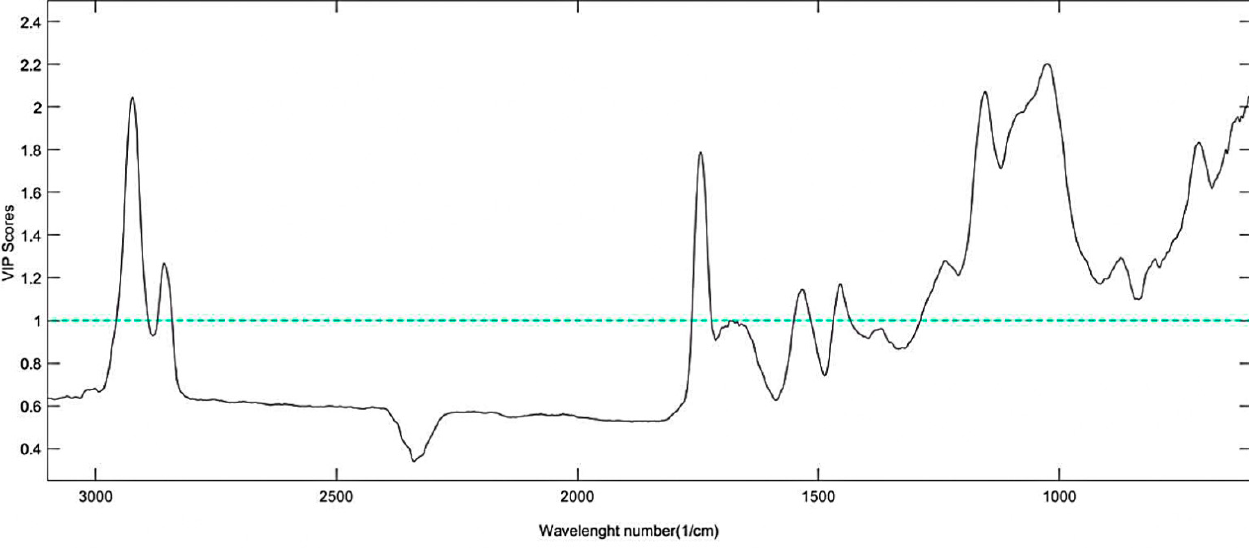
Figure 5. VIP Scores of the PLS models based on FTIR data.